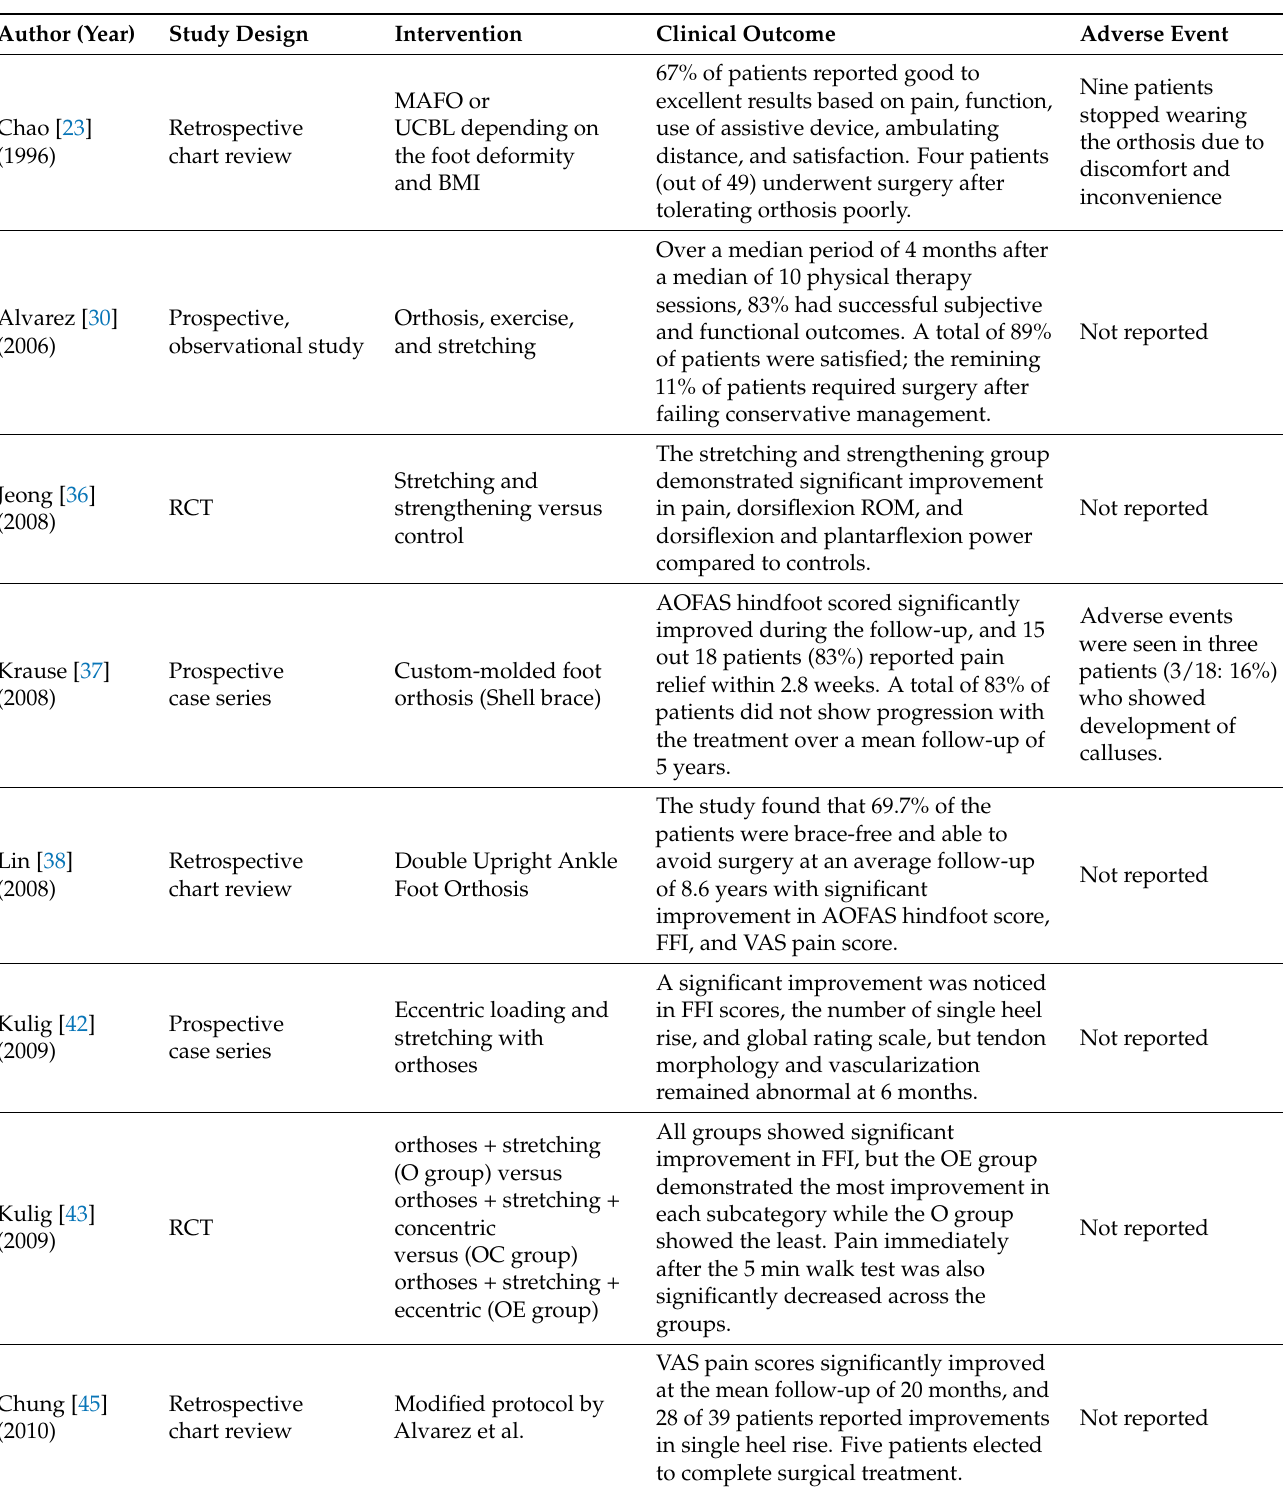
Table 3. Summary of findings from studies on non-surgical